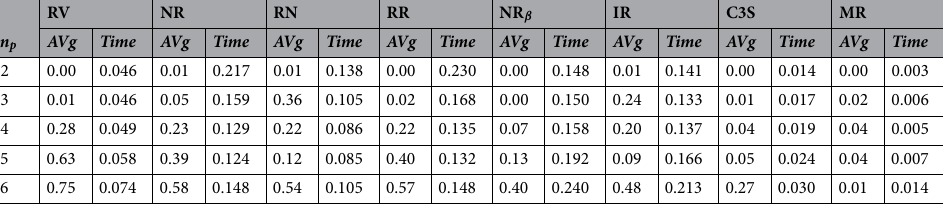
Table 10. AVg and Time variations according to n p for all algorithms.